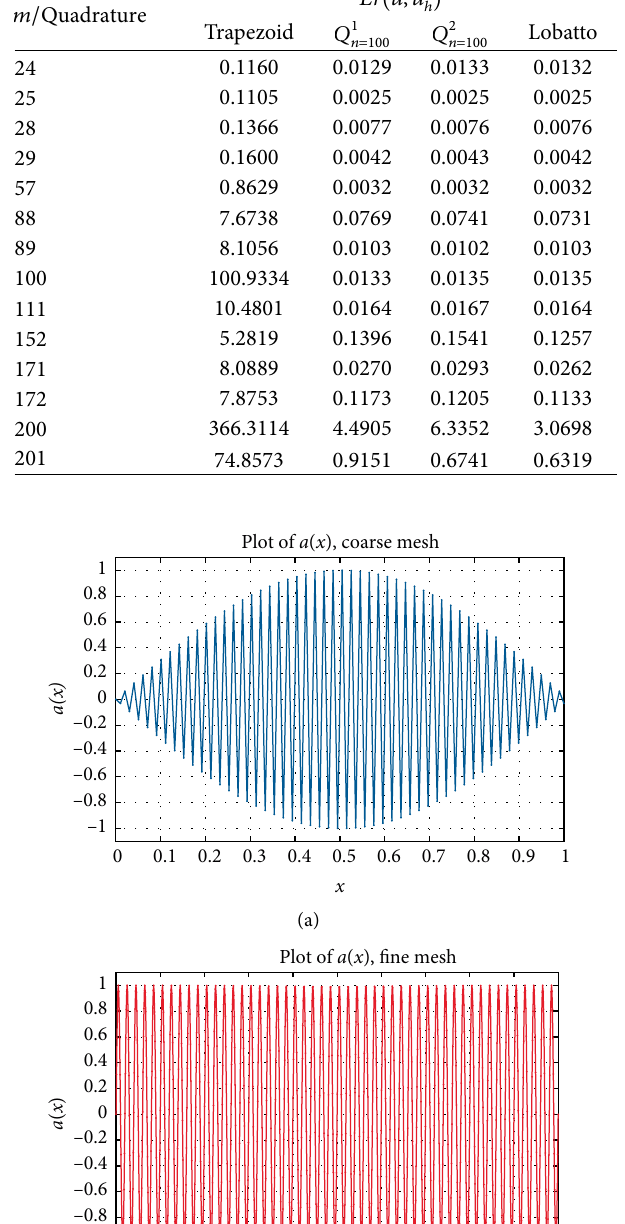
, with . (a) Coarse 𝑎(𝑥) 𝑚 = 100